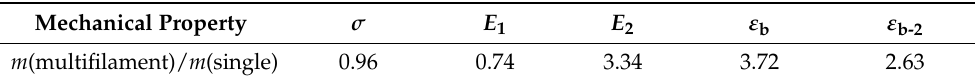
Table 3. Comparison of the Weibull’s modulus m for single and multifilament PA 6 fibers for some mechanical